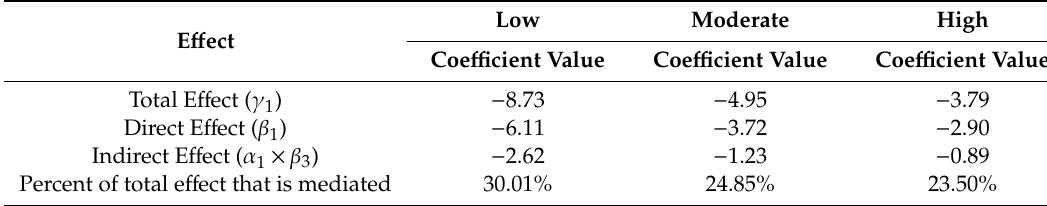
Table 7. Identification of mediation e ff ects for subgroups.